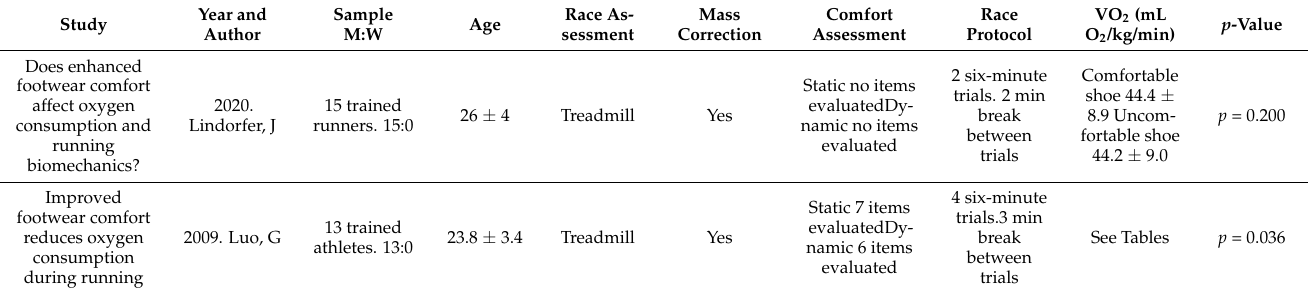
Table 5. Comfort Feeling.